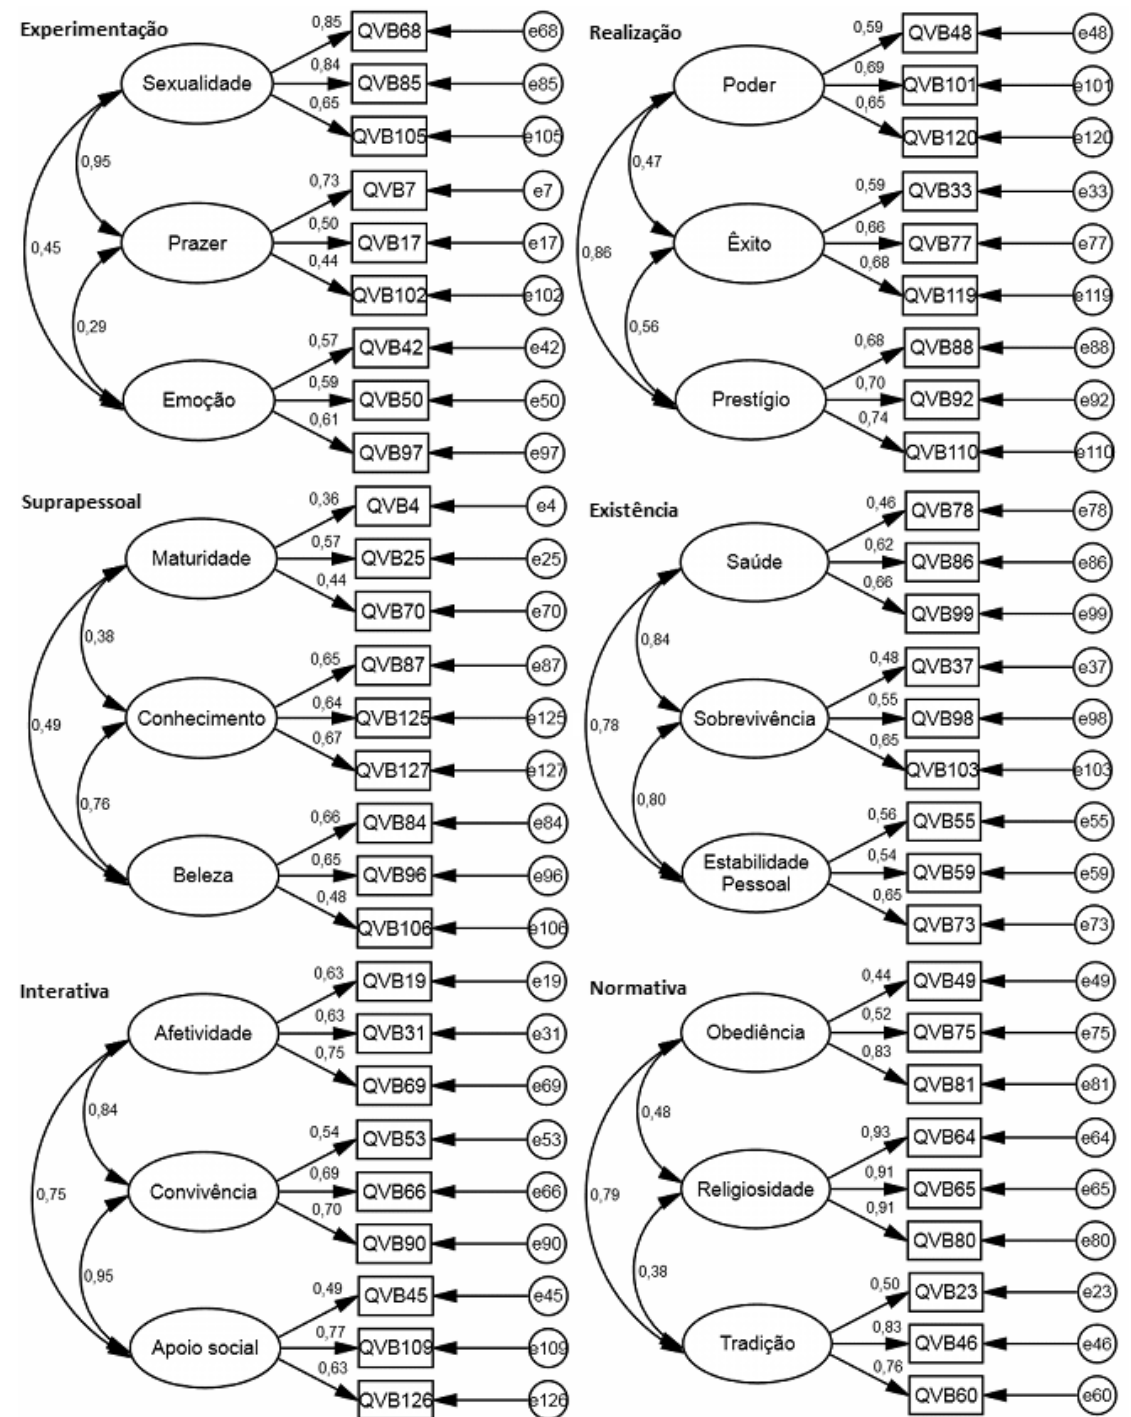
Figura 2 . Estrutura fatorial das subfunções valorativas do